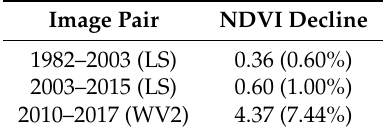
Table 2. Decline in NDVI (< − 0.05) for image pairs in km 2 (percent of study area).